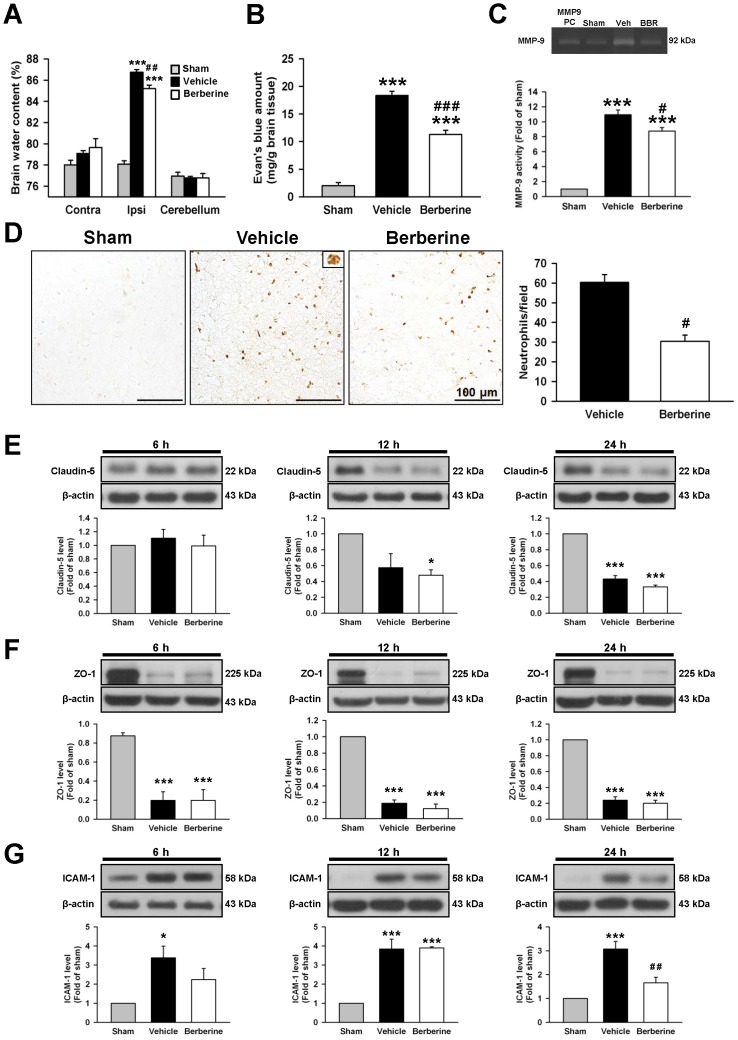
Post-injury berberine treatment attenuated brain edema, blood-brain barrier (BBB) permeability, matrix metalloproteinase (MMP)-9 enzymatic activity, neutrophil infiltration and ICAM expression after TBI.Berberine (10 mg·kg−1) significantly decreased (A) brain water content and (B) leakage of Evans Blue into the brain and in the ipsilateral hemisphere compared with the vehicle-treated mice. (C) Representative zymography of MMP-9 activity from a sham-injured control, a 10 mg·kg−1 berberine-treated, and a vehicle-treated mouse at 1 day post-TBI including the MMP-9 standard as a positive controls (PC). The gelatinase activity of MMP-9 was significantly decreased in berberine-treated mice compared with vehicle-treated mice. (D) Representative myeloperoxidase (MPO)-stained brain sections from a sham-injured control, a 10 mg·kg−1 berberine-treated, and a vehicle-treated mouse at 1 day post-TBI. The inset is a representative MPO-positive cell at higher magnification. Cell count analysis shows that berberine-treated mice had significantly fewer infiltrating neutrophils than vehicle-treated mice in the cortical contusion margin at 1 day post-TBI. The number of MPO-positive cells is expressed as the mean number per field of view (0.8 mm2). Scale bar, 100 µm. Western blot analysis of (E) claudin-5, (F) zonula occludens 1 (ZO-1), and (G) intercellular adhesion molecule (ICAM)-1 levels in the ipsilateral hemisphere of sham-injured, vehicle-treated, and 10 mg·kg−1 berberine-treated mice at 6 h, 12 h, and 1 day post-TBI. Treatment with 10 mg·kg−1 berberine did not affect TBI-mediated reduced expression of claudin-5 or ZO-1 at any tested time-points but attenuated ICAM-1 expression at 1 day. Values are mean ± SEM; *
P<0.05, ***
P<0.001 vs. the sham group; #
P<0.05, ##
P<0.01 vs. the vehicle group as determined by one-way ANOVA (n = 5–7 mice/group for brain water content, Evans Blue amount, MMP-9 activity and n = 4–6 mice/group for all Western blot analysis). Values are presented as means ± SEM; #
P<0.05 vs. the vehicle group as determined by the Student's t-test (n = 5–6 mice/group for MPO staining).